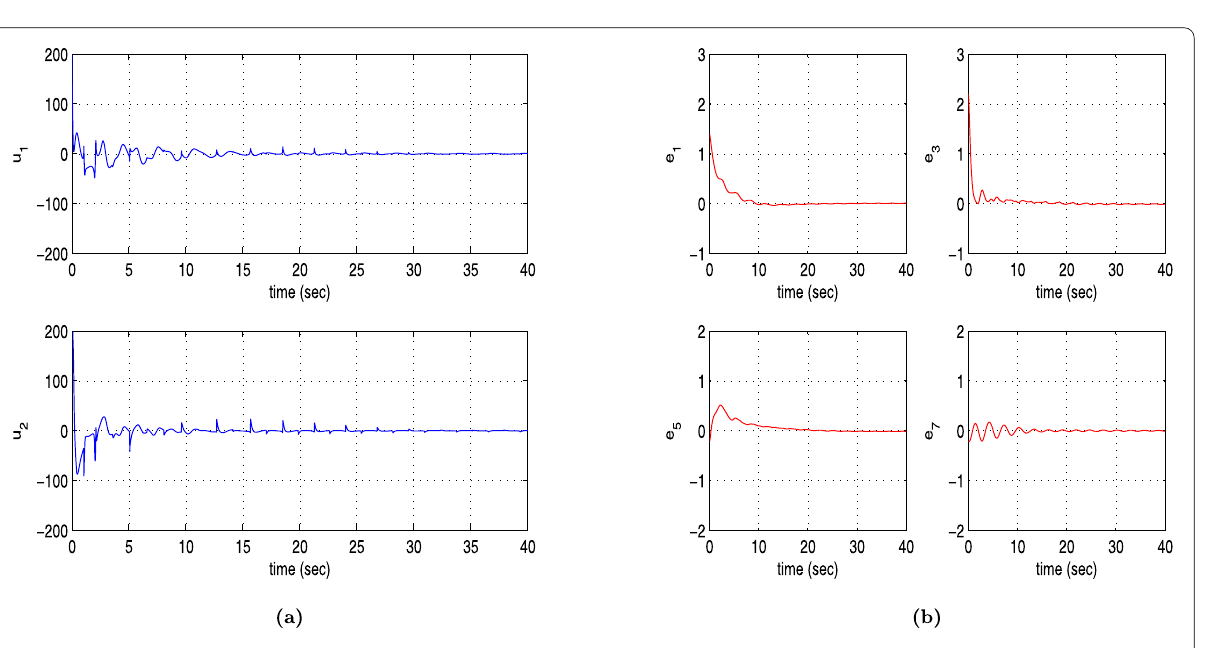
with the value of the state vector at each sampling instant as well as with the last sampled value of the control inputs vector. The Riccati equation which has been proposed